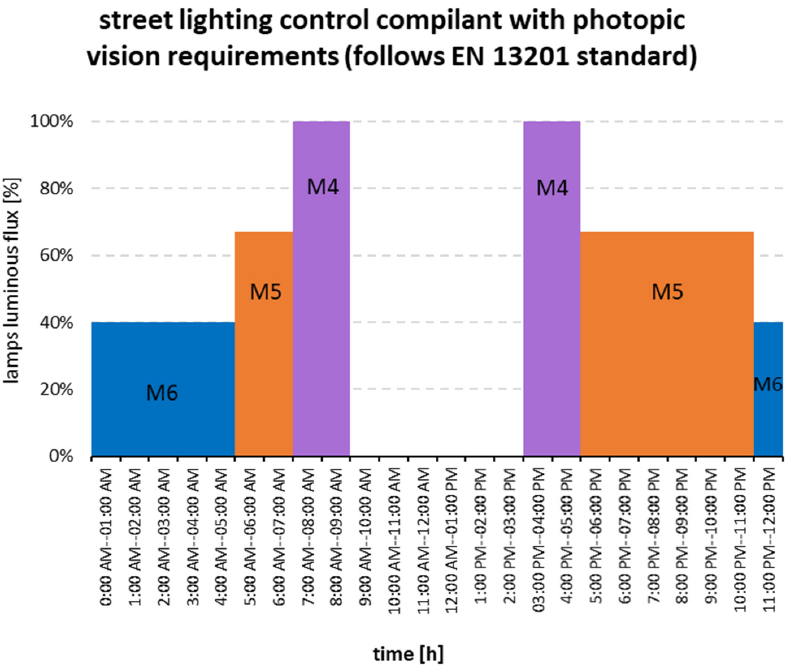
Figure 13. Lighting control profile—case 1 where the control system performs the control to ensure road luminance levels are compliant with EN 13201 standard (lighting scenario number 1).